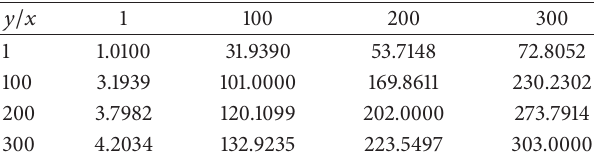
Table 2: Monotonic surface data